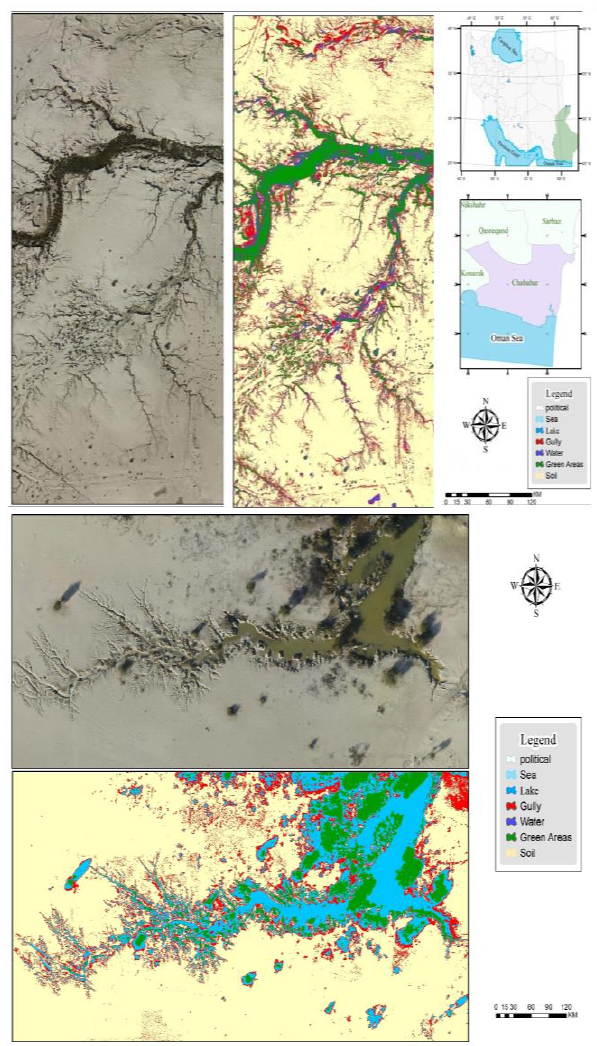
Figure 7. The result of classified gullies with machine-based